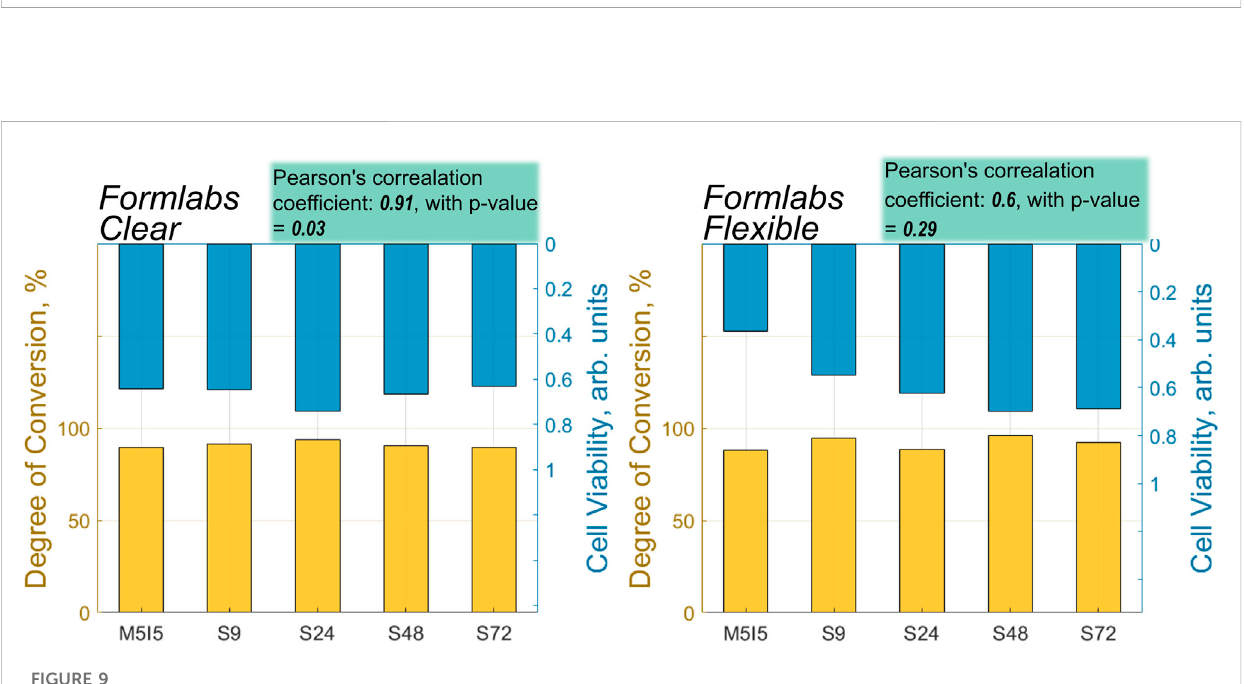
Frontiers in Bioengineering and